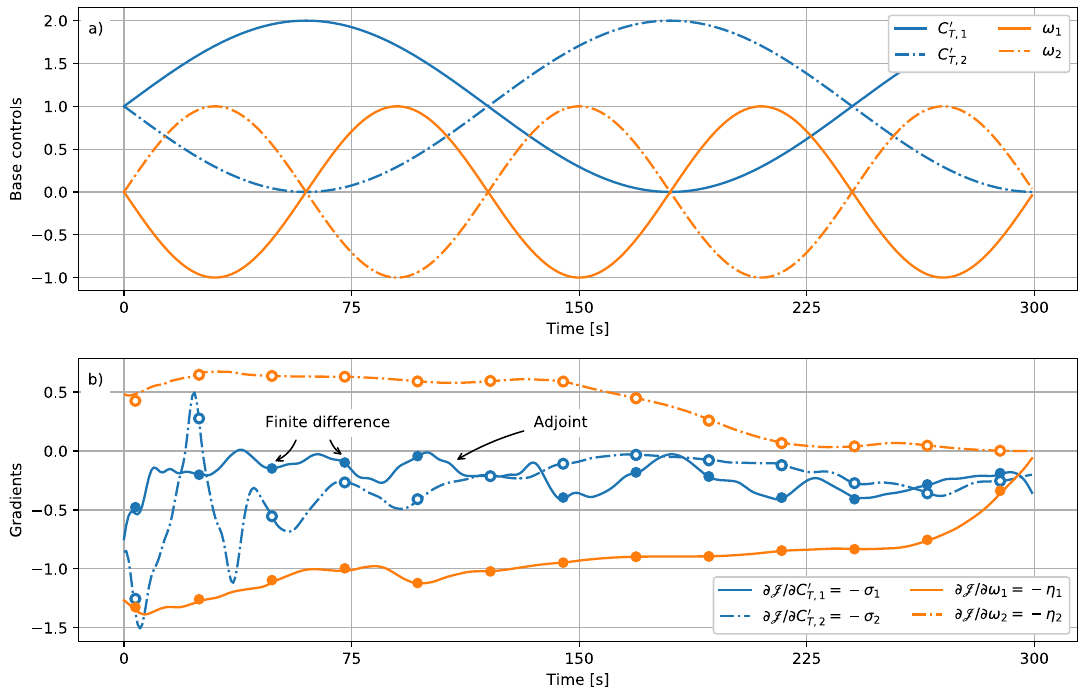
Figure A3. Adjoint gradient verification case. ( a ) Baseline controls around which linearization is performed. ( b ) Cost functional gradient. Full lines: adjoint, dots: finite